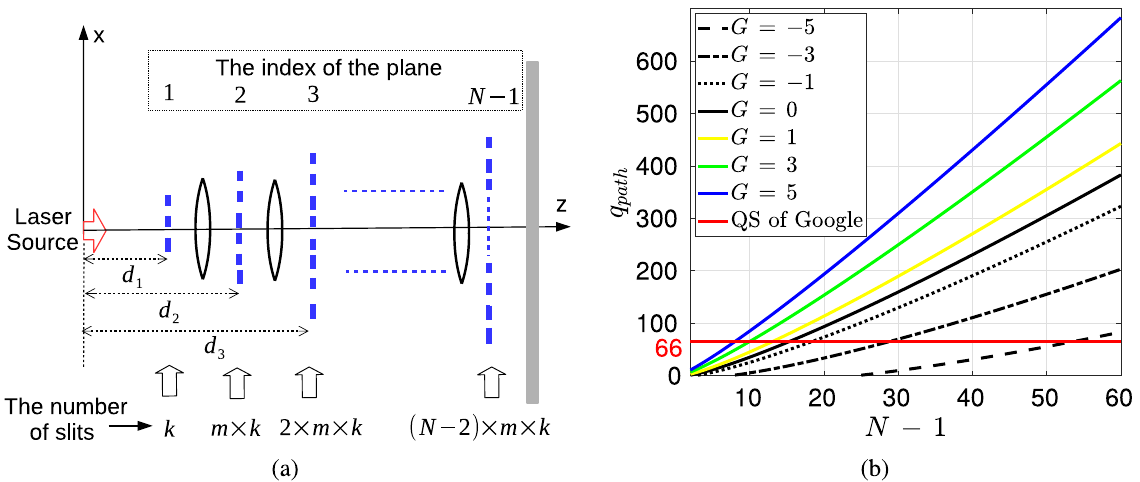
1 planes diffracts the quantum wave function expanding with Figure 5. ( a ) The special QPC design with N − planes consisting of a linearly increasing number of slits. The positions of the planes ( d j ), the number of slits ( k ) m k , allow flexible in the first plane and the linear increment ratio m , i.e., the number of slits growing with j × × design according to the width of the laser beam. ( b ) The virtual qubit Hilbert space size corresponding to the number of Feynman paths versus the number of planes for varying gain variable ( G ). QS experiments of Google have recently been performed